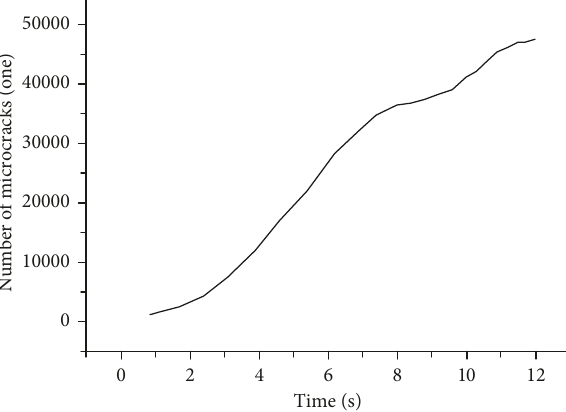
Figure 14: Relation curve of microcrack number and load time.